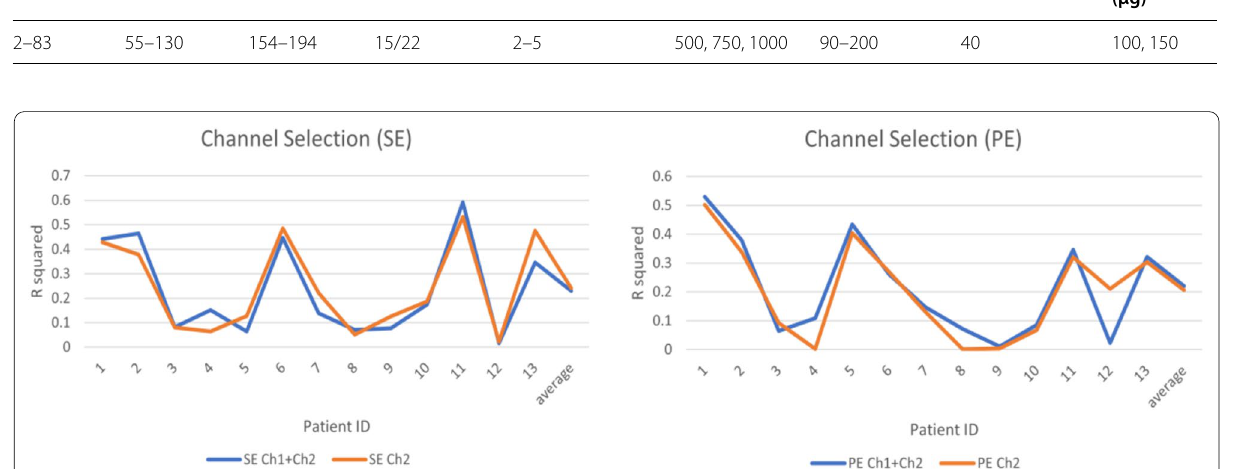
Fig. 2 The R 2 value of SE and PE from Ch1